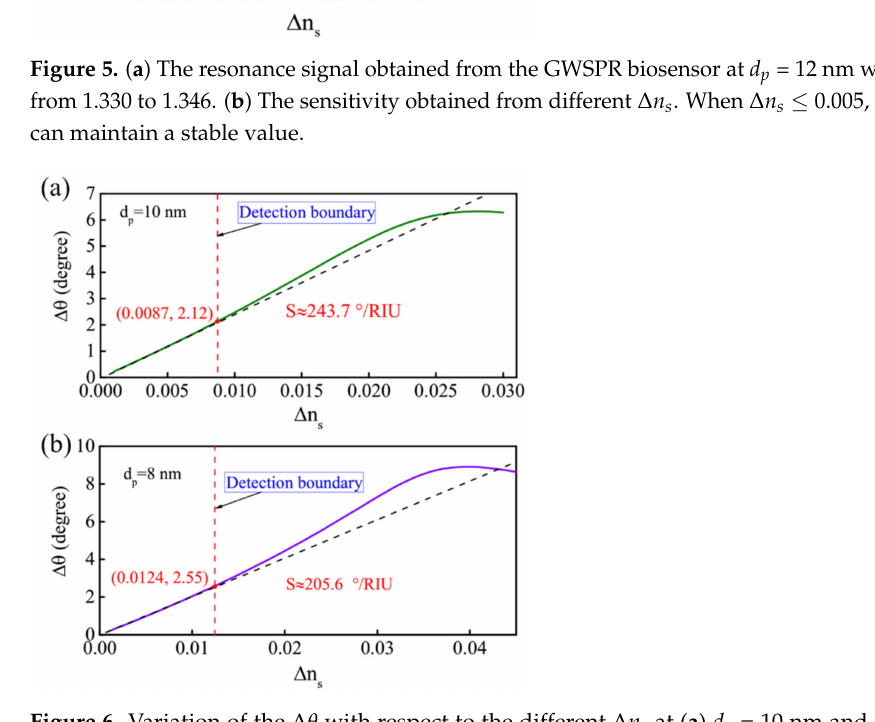
Figure 6. Variation of the ∆ θ with respect to the different ∆ n s at ( a ) d p = 10 nm and ( b ) d p = 8 nm. The results demonstrate that the optimal detection ranges are (1.330, 1.3387) and (1.330, 1.3424) at d p = 10 nm and d p = 8 nm, respectively. In these two ranges the sensitivity can keep in stable values of 243.7 ◦ /RIU ( d p = 10 nm) and 205.6 ◦ /RIU ( d p = 8